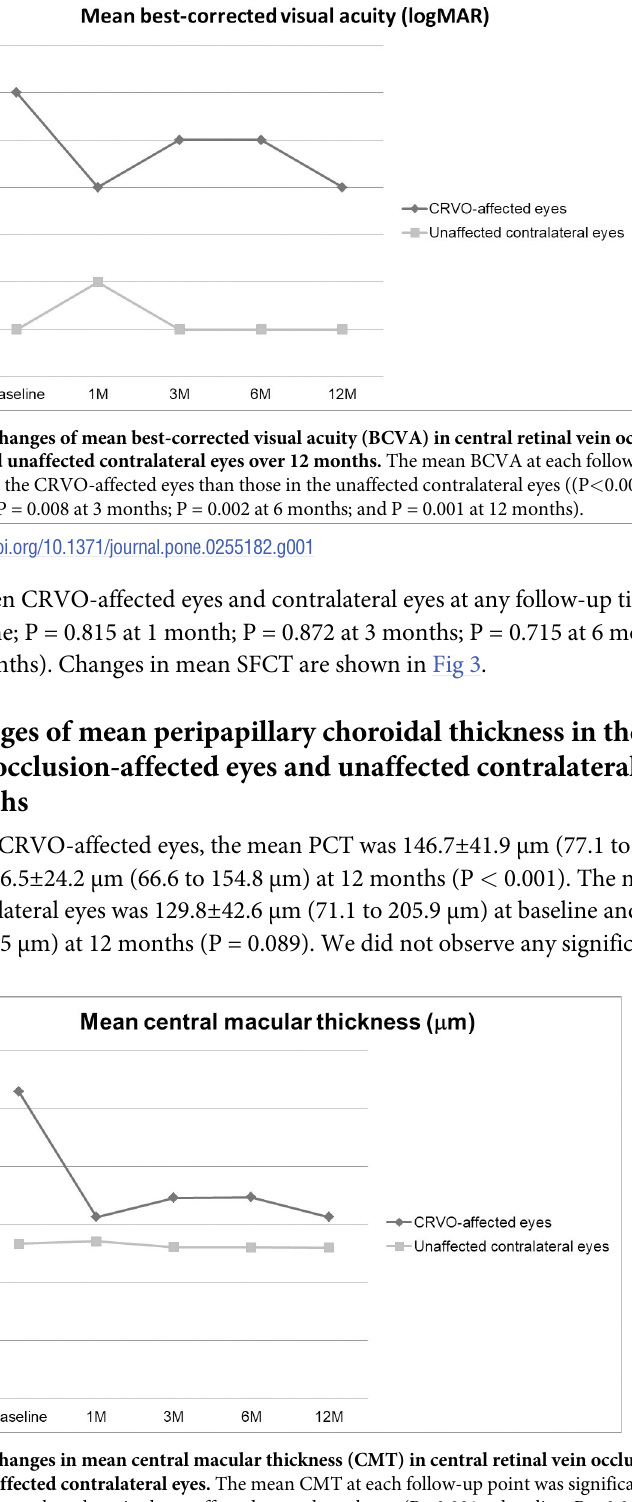
Fig 2. Changes in mean central macular thickness (CMT) in central retinal vein occlusion (CRVO)-affected eyes and unaffected contralateral eyes. The mean CMT at each follow-up point was significantly thicker in the CRVO- affected eyes than those in the unaffected contralateral eyes (P < 0.001 at baseline; P = 0.017 at 1 month; P = 0.007 at 3 months; P = 0.005 at 6 months; and P = 0.027 at 12 months).